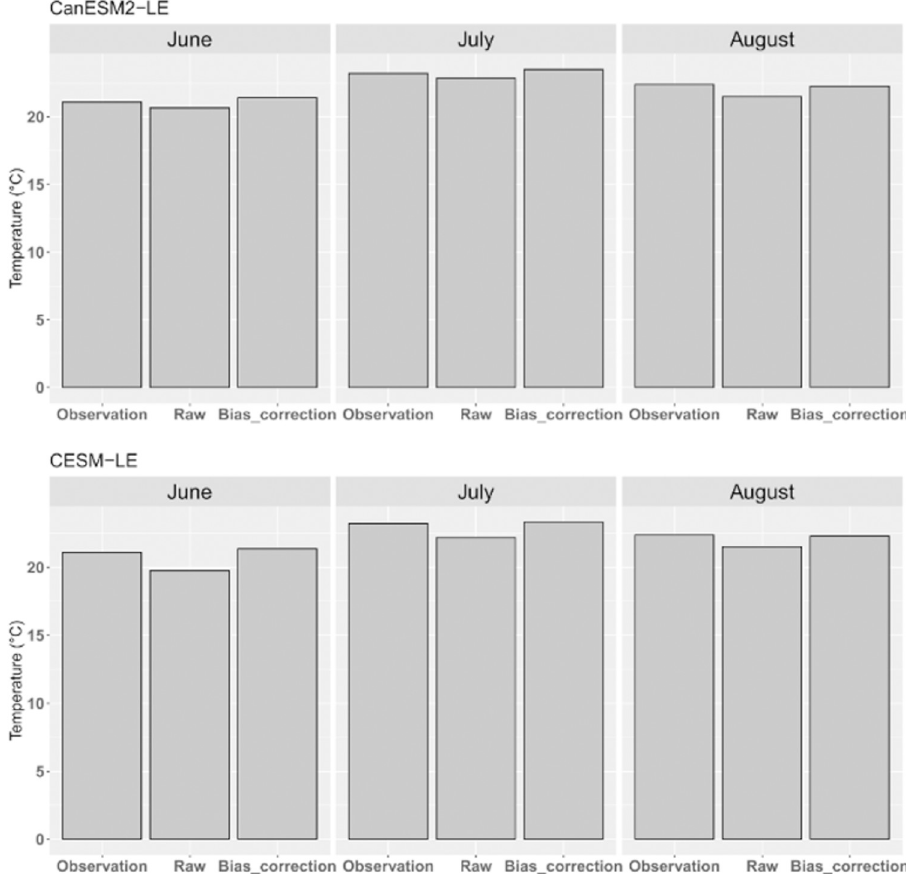
Fig 2. Regional mean temperatures in June, July and August during current climate (1.0˚C warming relative to pre-industrial period) in observations, raw simulations and bias-corrected simulations in CanESM2-LE and CESM-LE. Noted that the multi-member mean was used in the